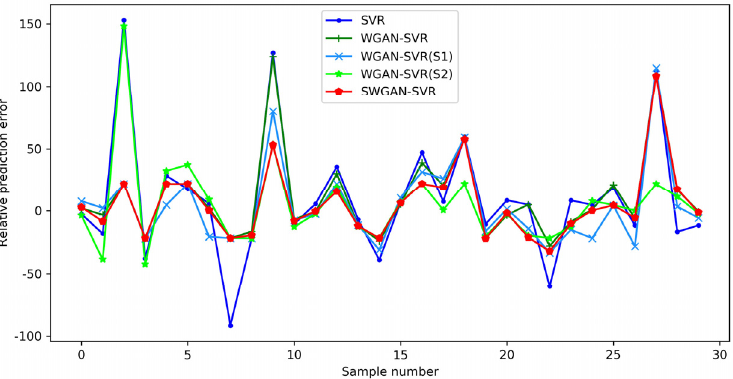
Figure 11. Relative prediction errors for the polyethylene process.